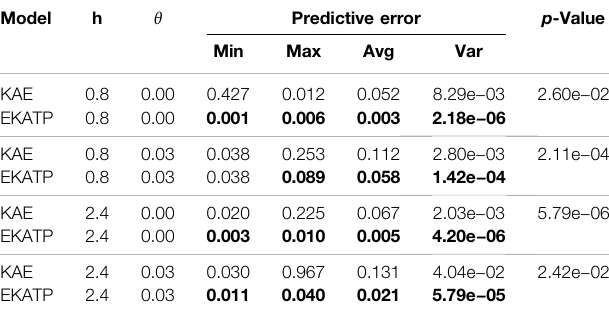
TABLE 1 | Predictive error at 1,000 steps for both the KAE and EKATP.